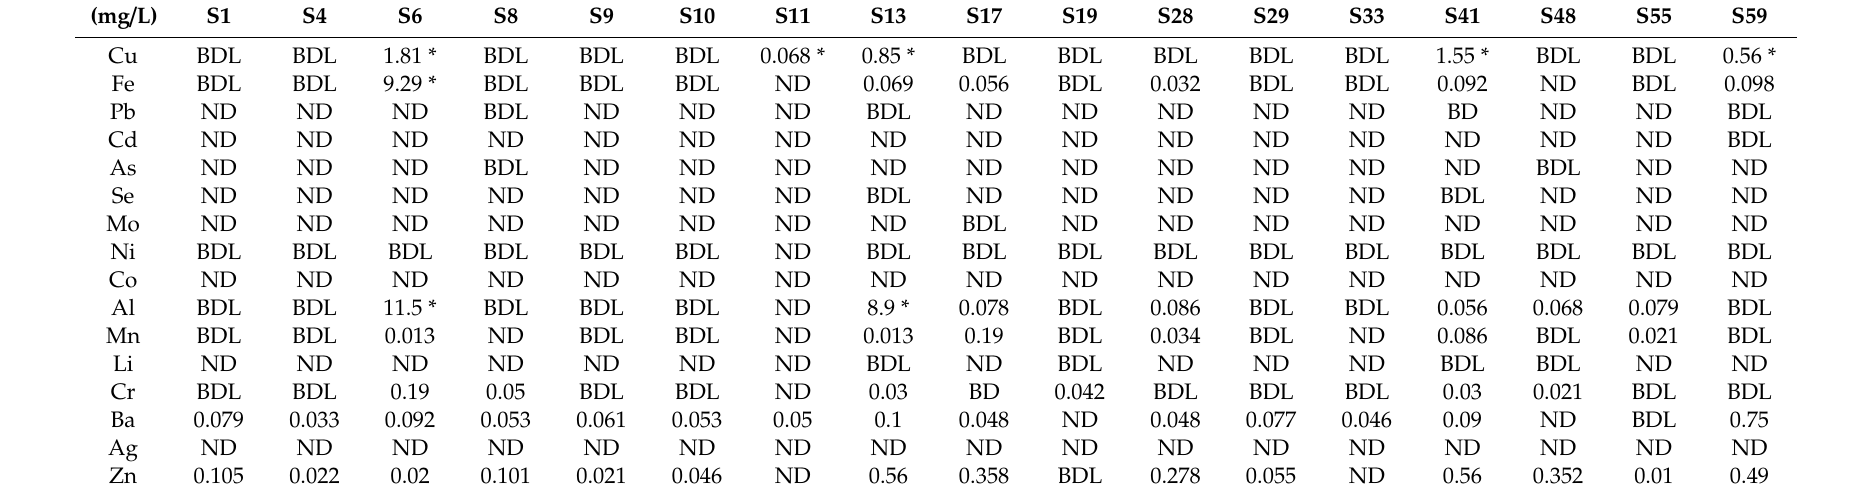
Table 4. Heavy metal concentrations of the collected condensate water